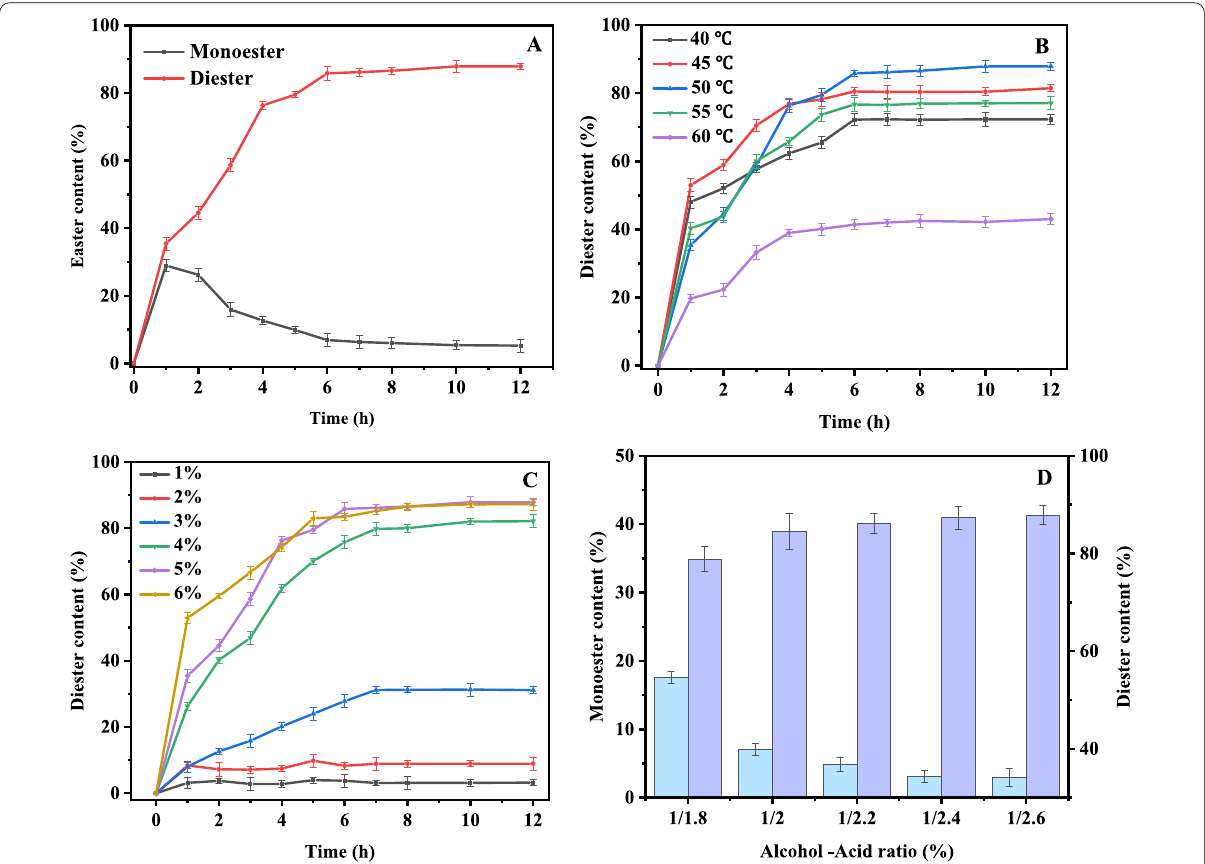
Fig. 3 Optimization of reaction conditions for the enzyme-catalyzed synthesis of PCM. A under certain conditions, LBE content changes with reaction time; B the change of LBE content with reaction time at different temperatures; C the change of LBE content with reaction time at different ratios of enzyme addition; D the relative percentages of LBE content in the product at different acid–alcohol